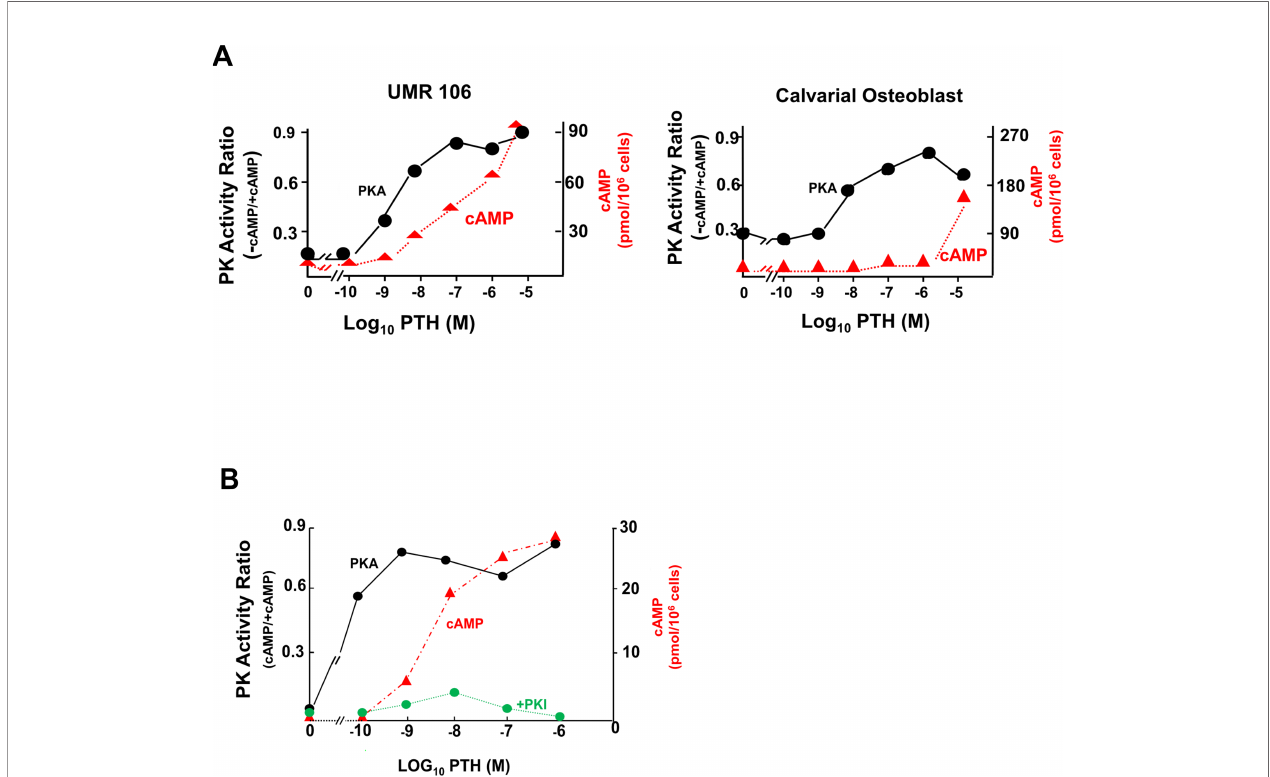
FIGURE 2 | Total cellular cAMP (in red) and activation of PKA (in black) in UMR106 osteogenic sarcoma cells and primary mouse calvarial cells. (A) dose-responsive effects of PTH after 60 seconds. (B) Activation of PKA by PTH (1 – 34) in relation to cAMP generation at 60 seconds, and speci fi c inhibition of phosphorylation by heat-stable protein kinase inhibitor (PKI) (from (42) with permission).